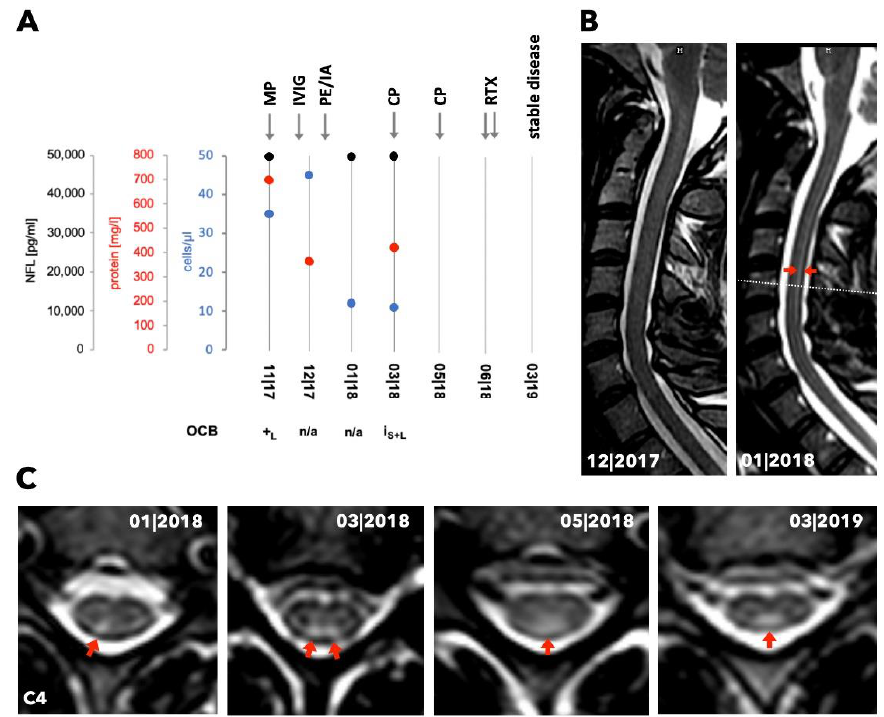
Figure 1. Longitudinal laboratory and radiological data and treatment changes for patient 1. ( A ) Chart shows the course of cell count, concentrations of protein and neurofilament light chain (NFL) as well as the occurrence of oligoclonal bands (OCB) in the CSF over time (n/a = not examined, + L = detected in CSF, I S+L = identical OCB in serum and CSF). Arrows indicate time points of treatment (MP = methylprednisolone, IVIG = intravenous immunoglobulin, PE/IA = plasma exchange/immunoadsorption, CP = cyclophosphamide, RTX = rituximab). ( B ) Panel displays MRI (T2 sagittal plane) at two different time points. The red arrows indicate the T2-enhancement of the posterior part of the spinal cord. The dotted line presents the height of the transversal planes shown in (C). ( C ) Transversal planes of the cervical spinal cord (C4) show T2-enhancement over time in the posterior columns, indicated by the red arrows.